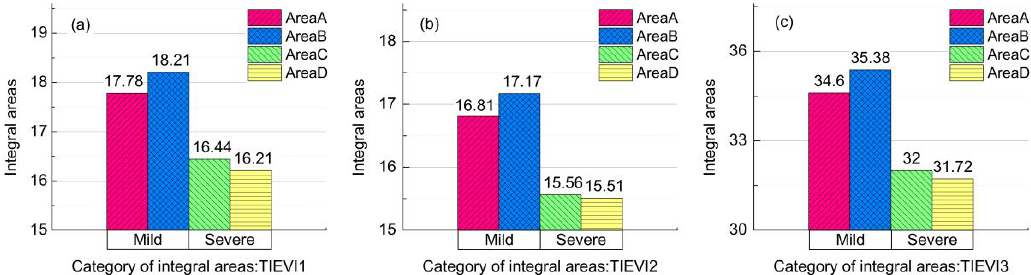
Figure 7. The integral areas of EVI time series during the three phenology periods (the tillering period, the heading period, the maturation period): ( a ) TIEVI1 exhibits the integral areas between the tillering period and heading period, ( b ) TIEVI2 exhibits the integral areas between the heading period and maturation period, and ( c ) TIEVI3 exhibits the integral areas between the tillering period and maturation period, from the four experiment areas (Area A, B, C, and D), respectively.